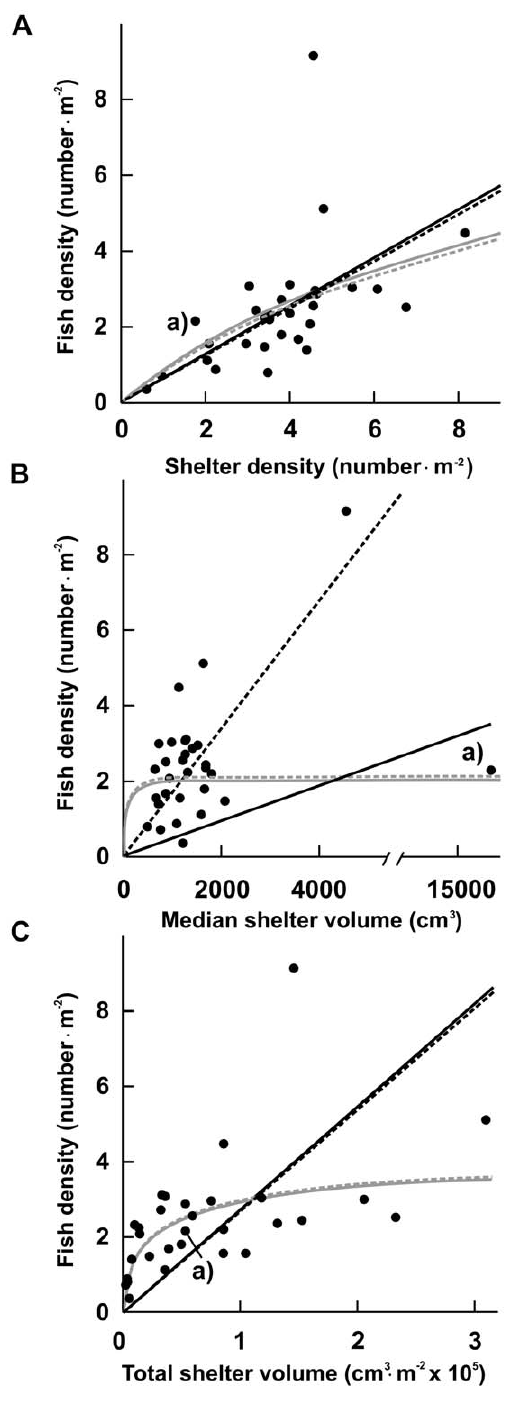
Figure 5. Relationship between fish density and shelter availability characteristics. The relationship between fish density (number m 2 2 ) and A) shelter density (number m 2 2 ), B) median shelter volume (cm 3 ) and C) total shelter volume (cm 3 ? m 2 2 ) for the 30 quadrats sampled. The solid black line represents the best fit linear regression to the entire dataset, whereas the dashed black line represents the best fit linear regression without Quadrat 5 (point a). The solid grey line represents the best fit asymptotic curve to the entire dataset, whereas the dashed grey line represents the best fit asymptotic curve without Quadrat 5 (point a).